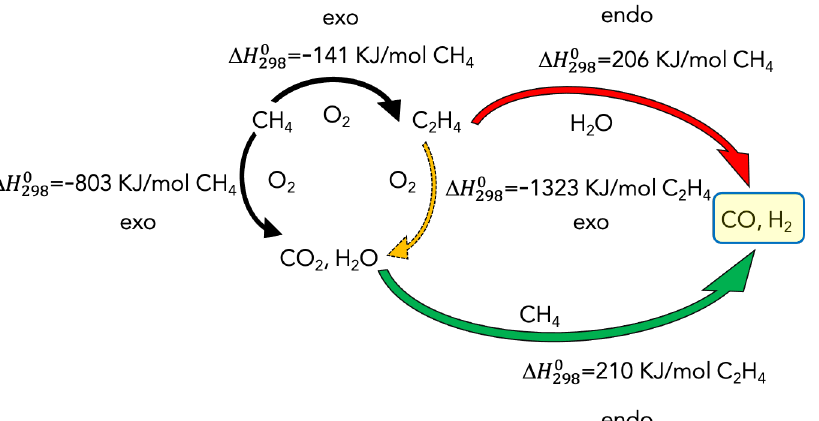
Figure 1. Example of oxidative coupling in autothermal reactions for the combined production of syngas and ethylene. See [17] for details. In parallel, lab-scale tools and new analytical methods based on operando-like spec- troscopies and the synergistic combination of complementary techniques (see, for exam- ple, all-dielectric optical antennas for mass spectrometry and Raman/FTIR spectroscopy multi-modal analysis) have been recently developed in order to characterize chemical re- actions in real-world conditions, getting rid of interferences that are usually caused by the use of conventional signal enhancers, such as plasmonic nanoparticles [20–26]. In-situ studies revealed that most of the heterogeneous catalysts evolve their struc- ture and microstructure during the process, so that their original properties are often very different from those observed in working regime [27,28]. In general, a progressive deacti- vation is a common fate for all the catalytic systems, however in many cases the perfor- mance of a catalyst reaches its maximum after several catalytic cycles. Smart “switchable” catalysts, able to respond and adapt to drastic changes of the ex- ternal parameters are going to be developed in many contexts [29]. These types of catalysts are designed to control diffusion dynamics and aggregation states as a function of changes of different stimuli—such as temperature, pH, ionic strength, light, magnetic, and electric fields. However, a systemic approach in catalyst’s design is not limited to the exploitation of these types of external stimuli, but aims at envisioning different scenarios during a cat- alytic reaction, in order to identify the most critical steps and, hopefully, transform limi- tations and drawbacks into advantages. This means that the horizons of several catalytic processes should be broadened through the interconnection/coupling among different and even concurrent reactions. To do that, a preliminary evaluation of all possible reac- tions occurring under working conditions should be carefully carried out. For example, the dry reforming methane reaction, CH 4 + CO 2 ⇄ 2 H 2 + 2 CO ΔH° = +247 KJ/mol